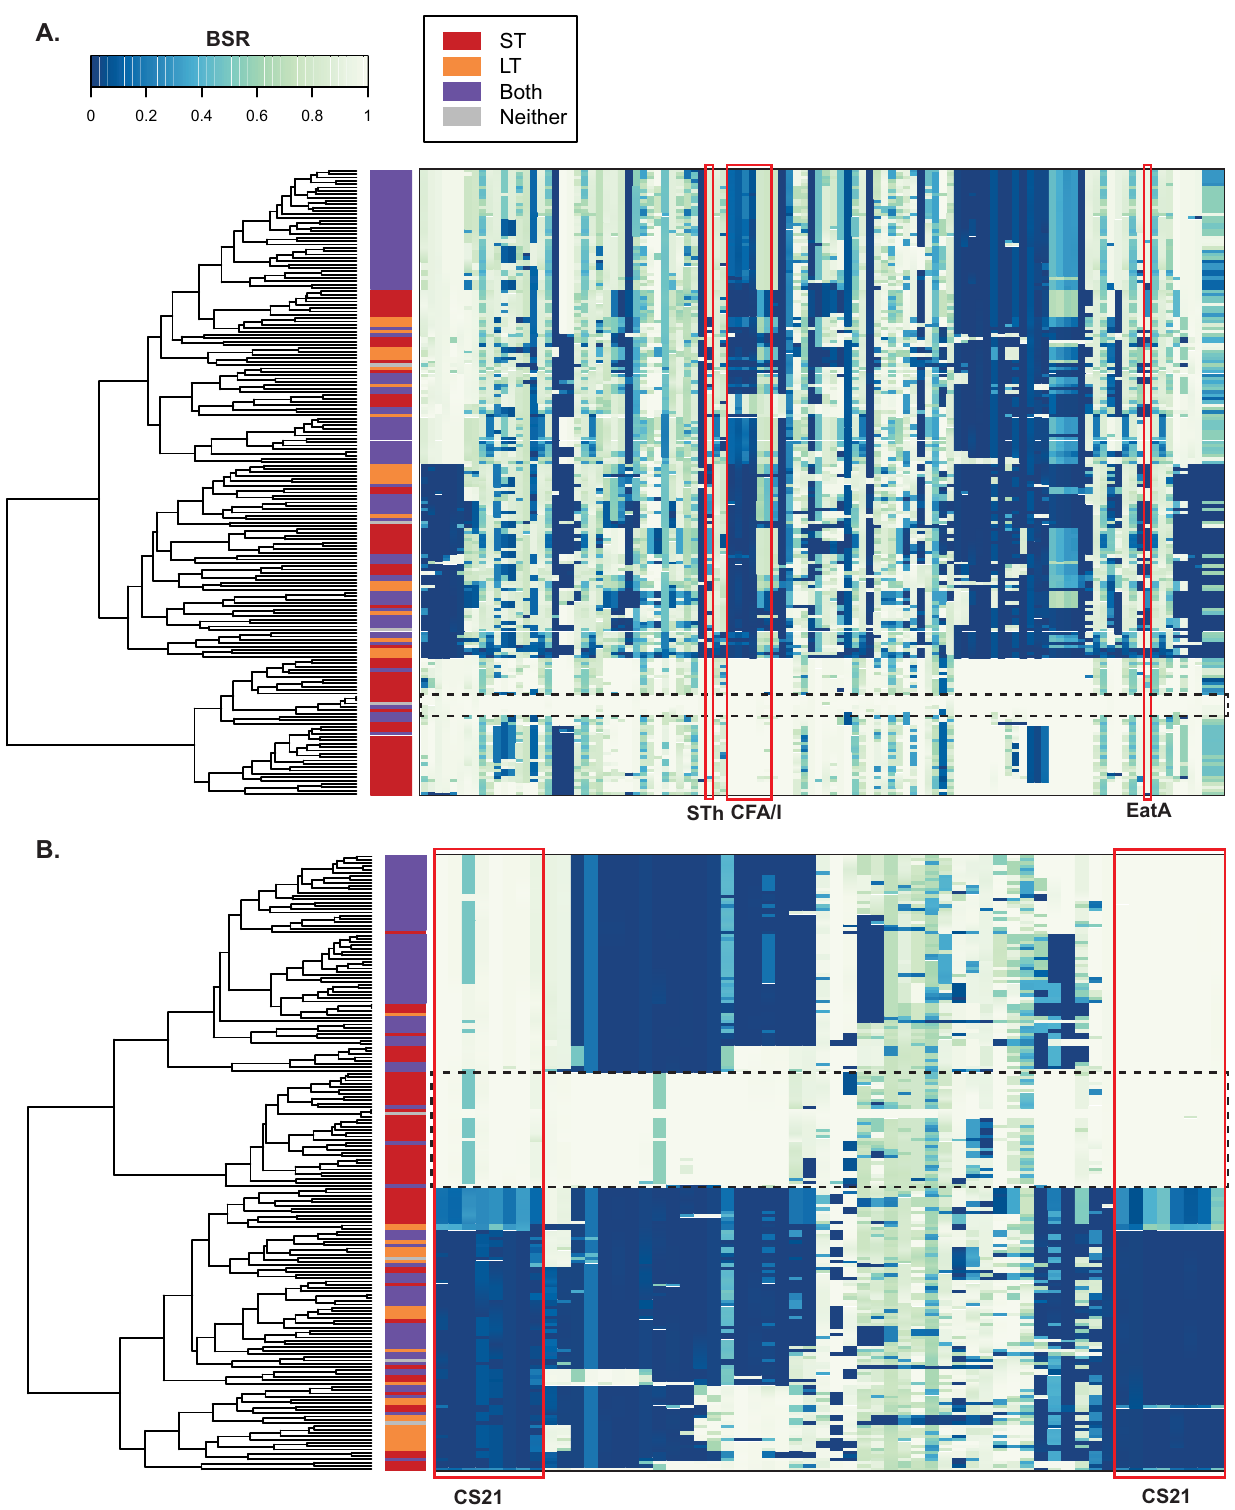
Fig 2. Distribution of virulence plasmids among the Chilean ETEC isolates. Heat maps indicate the presence of the virulence plasmids A) p10802a_92 and B) p10802a_46 among the Chilean ETEC and reference ETEC isolates analyzed in this study. The predicted protein-coding genes of each plasmid were